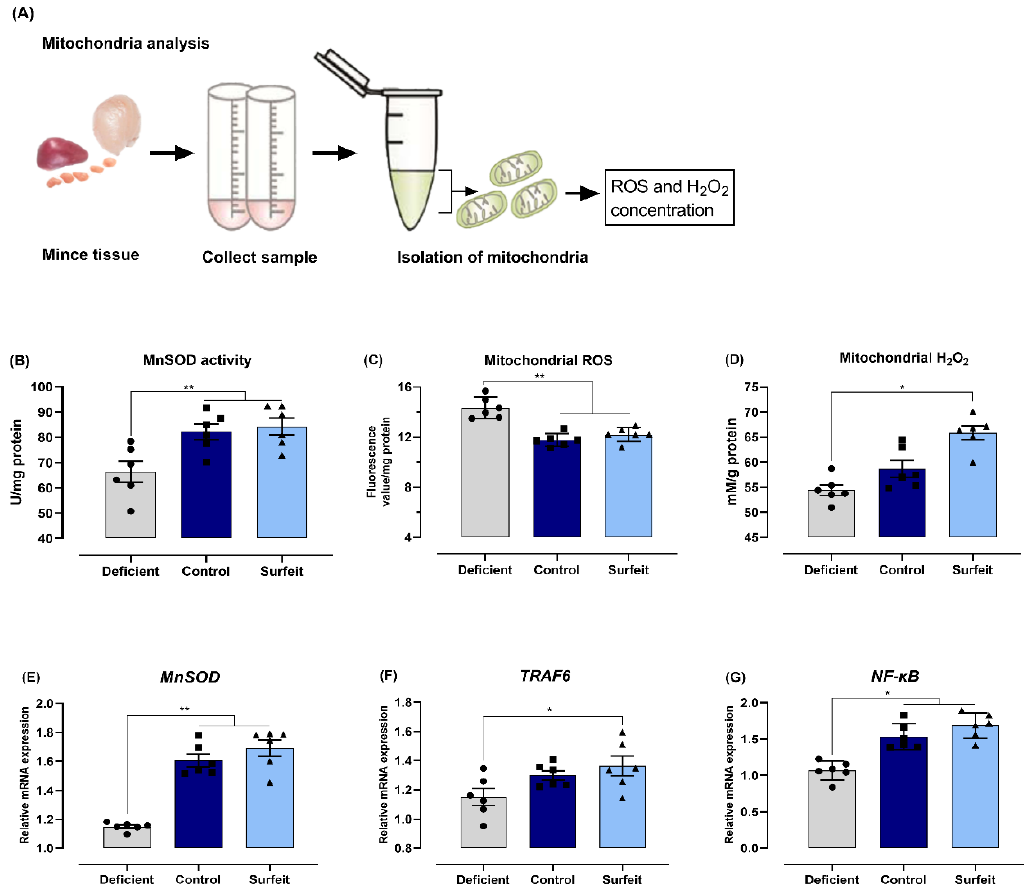
Figure 5. Mn supplementation associated with the activation of redox-sensitive signaling and downstream transcription factors. ( A ) Schematic diagram of extraction of mitochondria used in this study. ( B ) Manganese superoxide dismutase (MnSOD) activity, ( C ) reactive oxygen species (ROS) level, and ( D ) hydrogen peroxide (H 2 O 2 ) concentration were determined in mitochondria isolated from spleens of birds challenged with S . Typhimurium. Meanwhile, mRNA expression of ( D ) MnSOD, ( E ) tumor necrosis factor receptor-associated factor 6 (TRAF6), and ( F ) nuclear factor- κ B (NF- κ B) in spleen were measured by RT-PCR. Data represent means with standard deviation. * p < 0.05; ** p < 0.01.